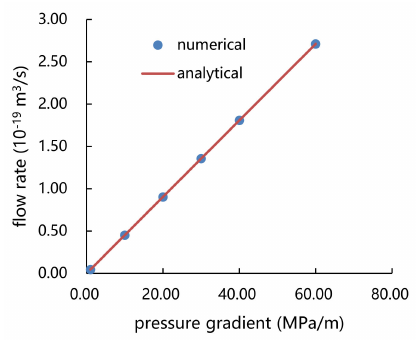
Figure 6. Comparison of flow rate.